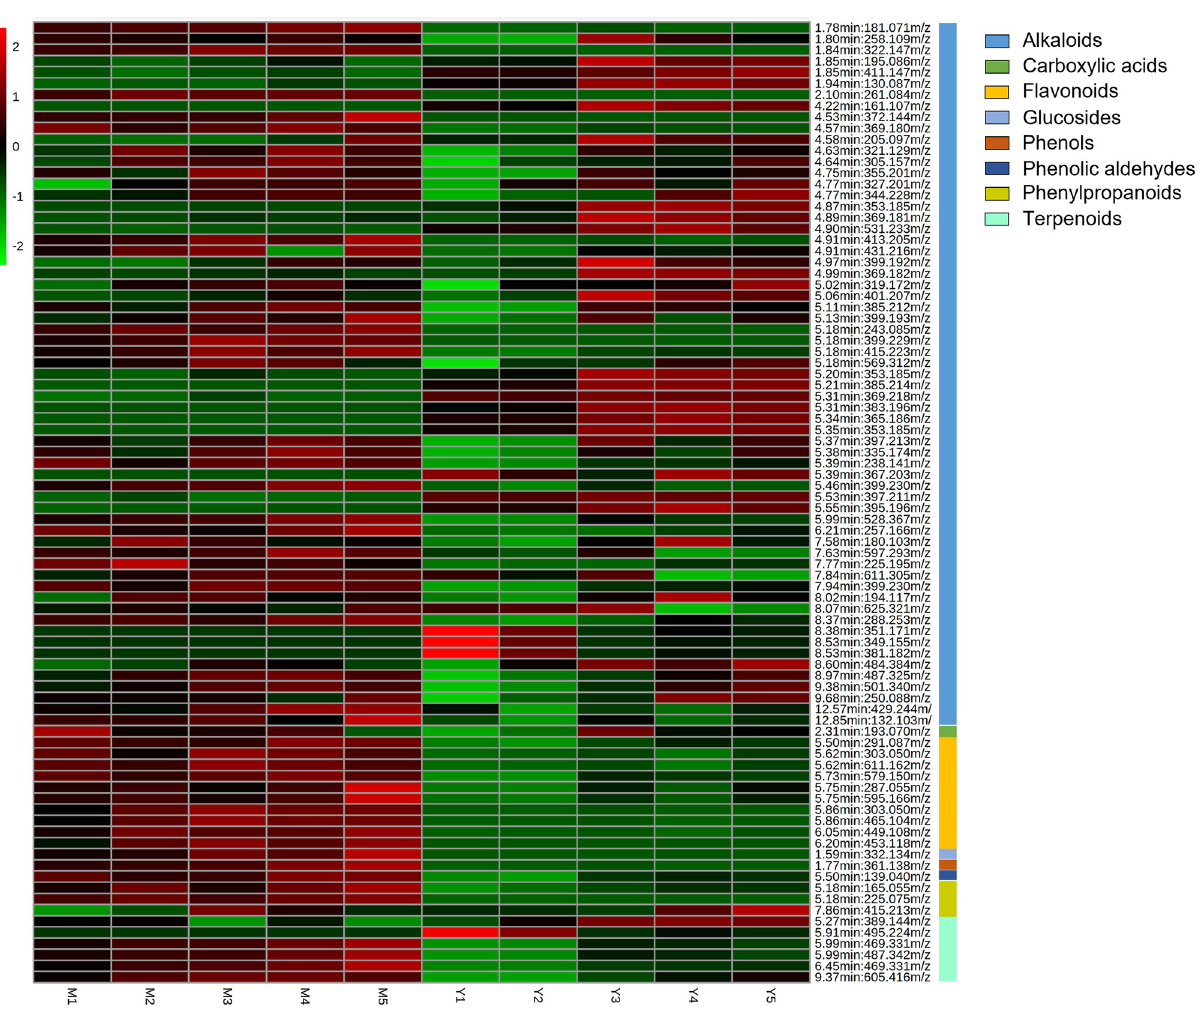
Fig 4. Heatmap showing the relative abundance of 86 metabolite features [RT(min):m/z] in young and mature leaves of M . speciosa . The scale bar of the heatmap indicates the relative abundance of the annotated metabolite features, with the lighter green colour representing lower intensity and the brighter red colour representing higher intensity. Annotation of each metabolite feature can be found in the S3 and S4